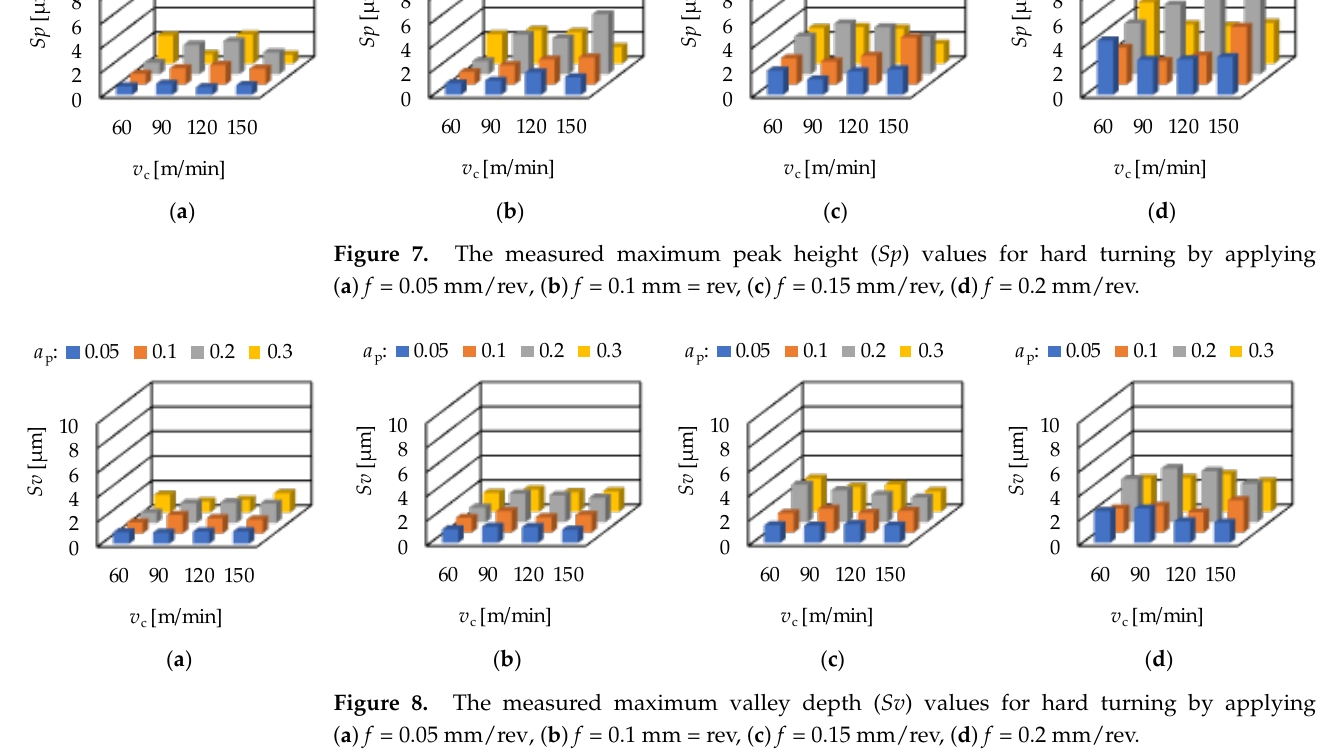
Figure 7. The measured maximum peak height ( Sp ) values for hard turning by applying ( a ) f = 0.05 mm/rev, ( b ) f = 0.1 mm = rev, ( c ) f = 0.15 mm/rev, ( d ) f = 0.2 mm/rev.